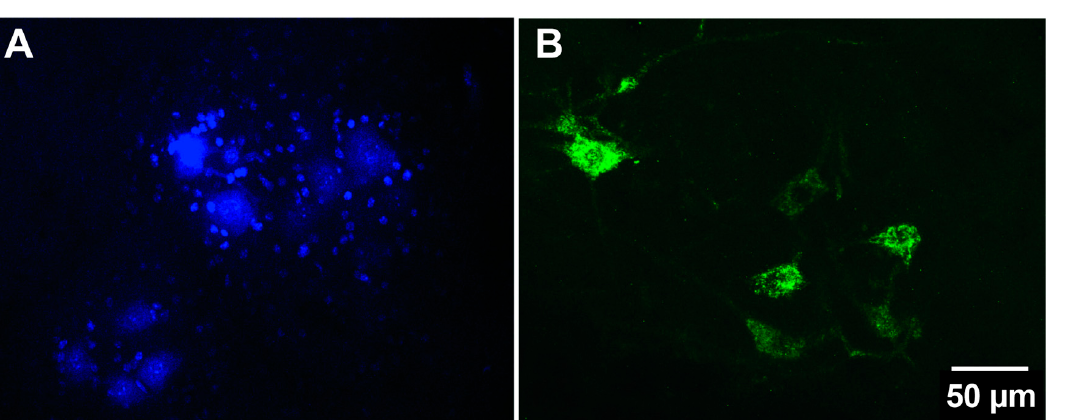
Figure 1. Neuronal labeling intensity ratio and difference among tracer protocols of young mice (6– 7 weeks). ( A ) An FB (2%, 5 ‐ day labeling intensity protocol) image taken from the tissue of a young mouse. ( B ) A CTB (0.1%, 5 ‐ day labeling intensity protocol) image taken from the tissue of a young mouse. ( C ) Intensity ratios (labeling/background intensity). The number of cells analyzed per group (from left to right in order) is 75, 83, 102, 87, 145, 155, 30, 30, 30, and 30. ( D ) Intensity difference for all experimental groups measured 4 days after fixation. The number of cells analyzed per group (from left to right in order) is 72, 83, 102, 87, 145, 155, 30, 30, 30, and 30. Data are median ± 95%